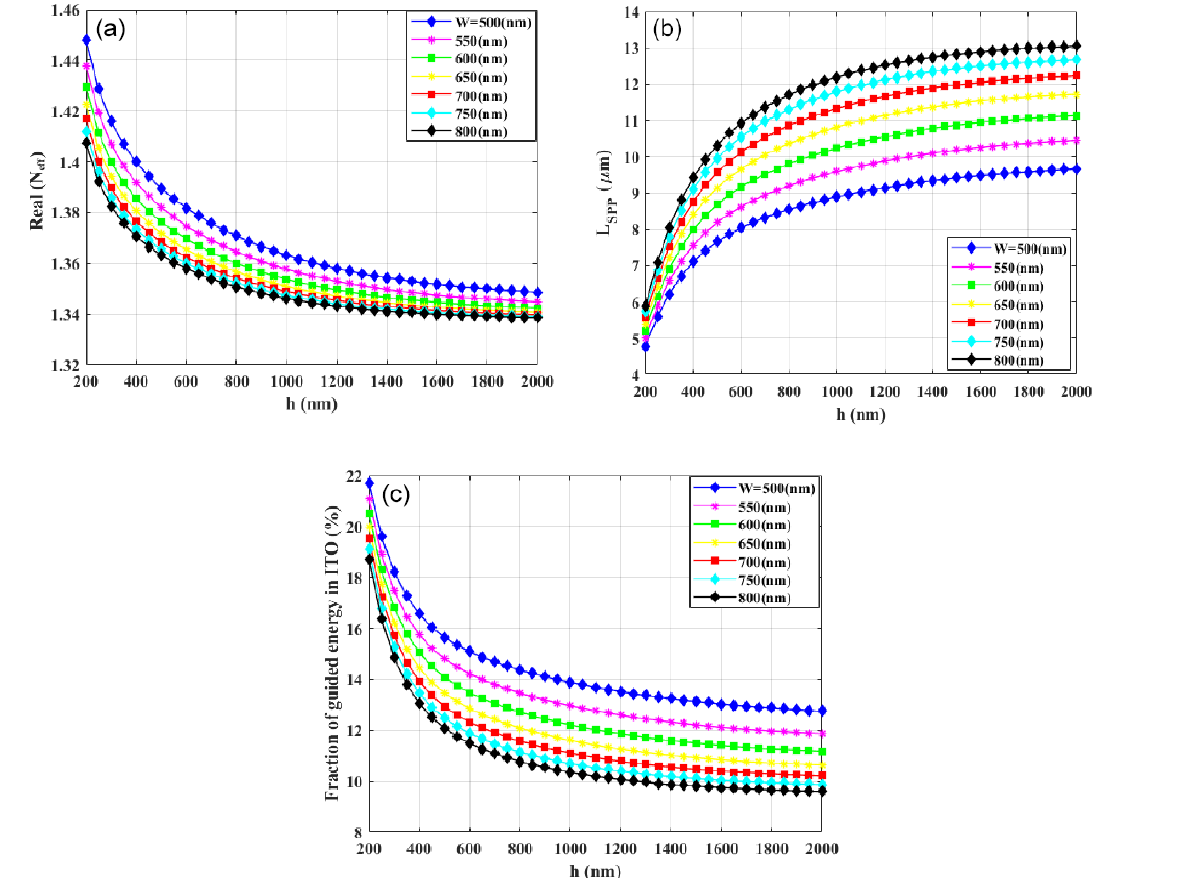
Figure 2. (a) The real part of the effective mode index ( N eff ), (b) the propagation length ( L SPP ) and (c) the fraction of guided electromagnetic energy in ITO versus slot height ( h ) for different slot widths ( w ).